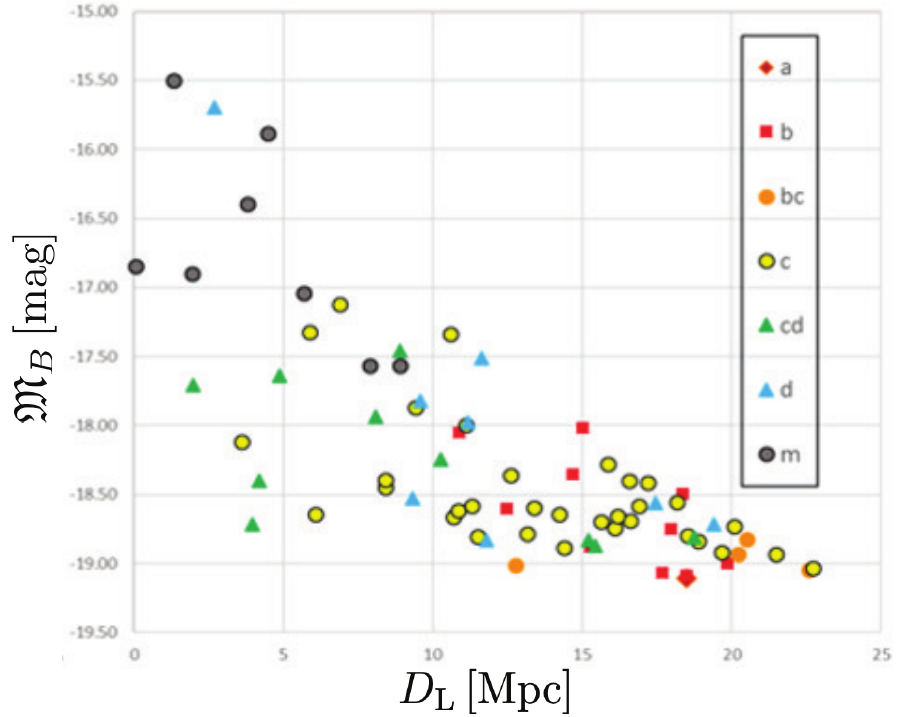
Figure 8. M B vs. D L diagram for just the faint sample, according to Hubble type. NB , Sm dwarf Hubble types comprise nearly all the galaxies fainter than M B = − 17mag, and all of these galaxies went unmeasured in pitch angle (see also Note 11